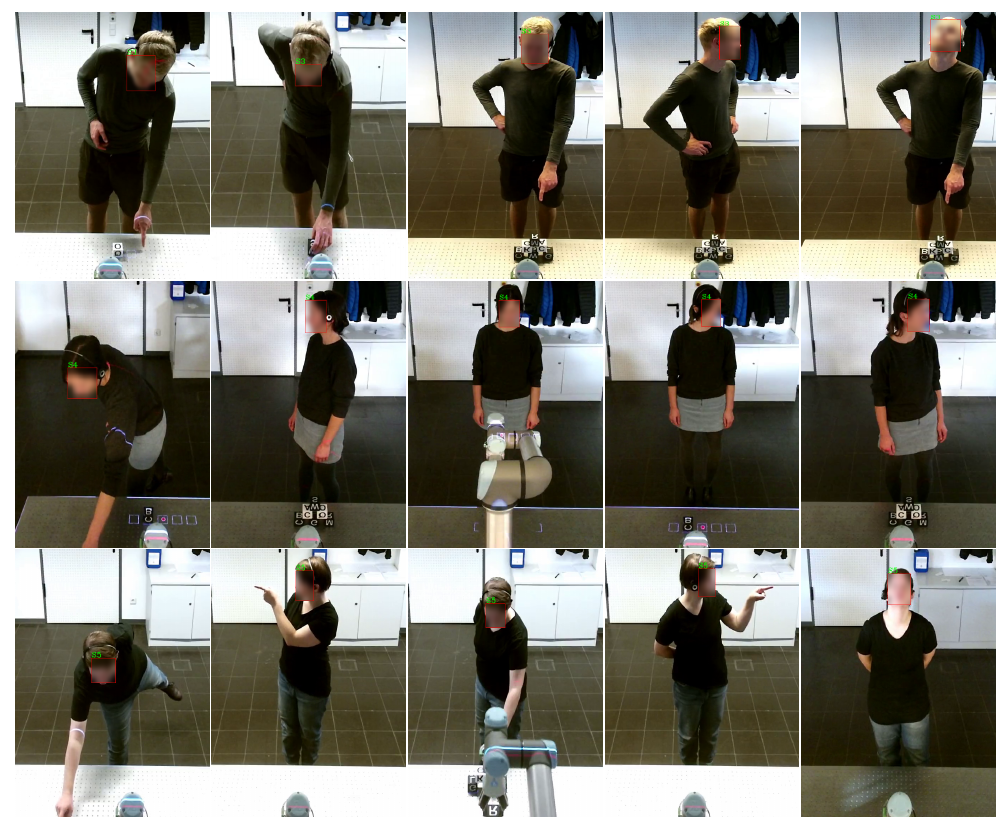
Figure 9. Experimental results of the proposed framework that shows the robustness of the framework against various head posture and illumination conditions.